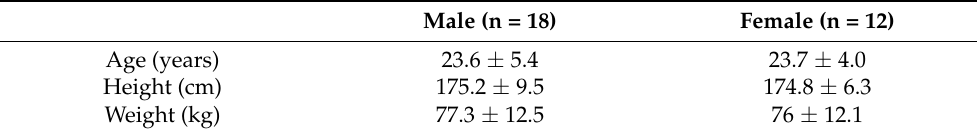
Table 1. Demographic characteristics of